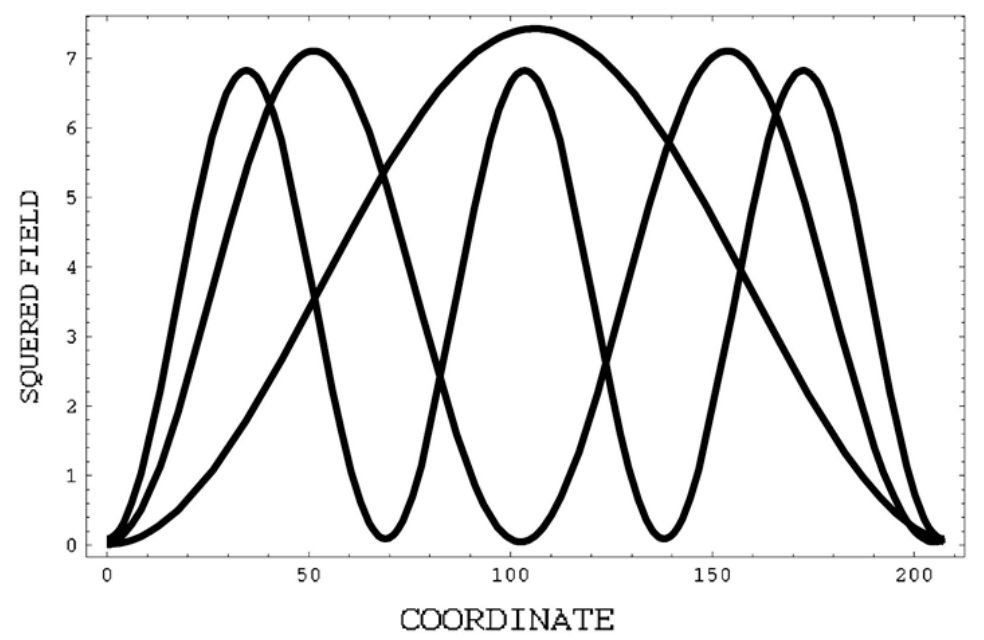
Figure 3. Calculated second order CEM energy density (arbitrary units) for the π - σ and σ - π polarization cases versus the coordinate (in the dimensionless units 2 z τ ) inside the layer for the three first second order CEMs ( δ 2 (cos 2 θ ) / 4sin θ = 0.05, N = 33, n = 1,2,3).